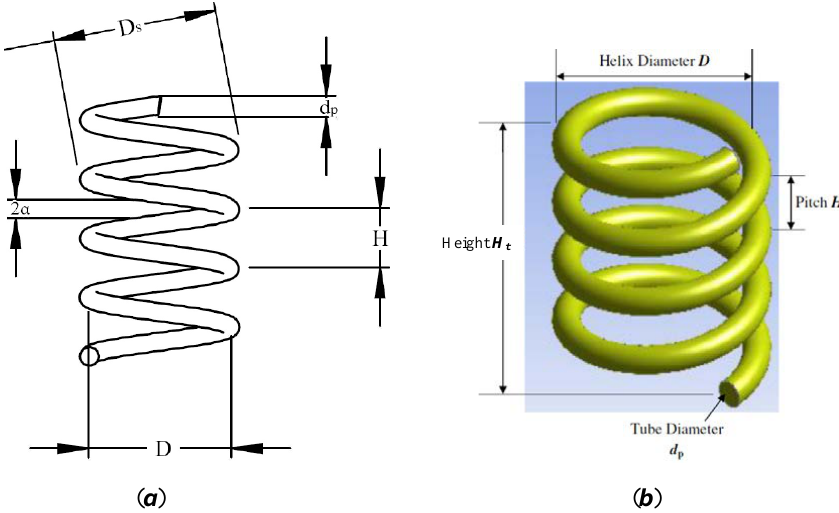
Figure 1. Typical geometry of spiral coil: (a) plane view and (b) isometric.